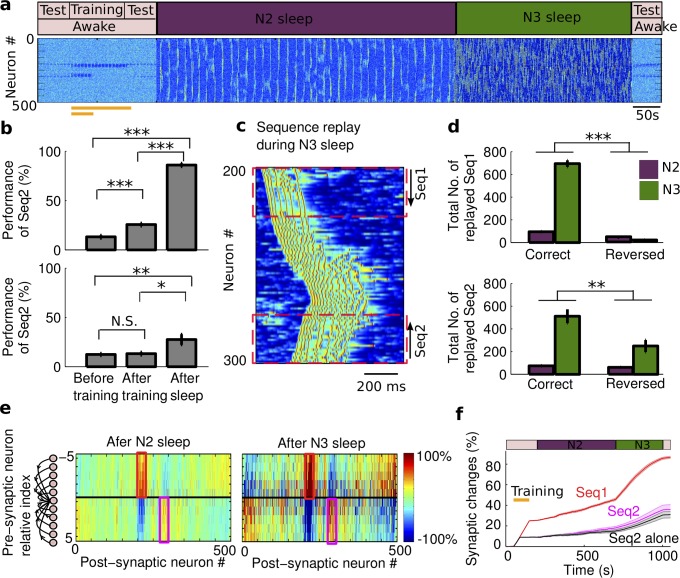
The role of sleep spindles during two-sequence learning.a) The model simulated transitions from awake to N2 sleep, to N3 sleep, and to awake again. Sequence training is the same as in Fig 3. b) The bar plots of performance for Seq1 and Seq2 during test sessions. Note significant increase in Seq2 performance after the sleep. Error bars indicate SEM. c) A characteristic example of sequence replay during slow oscillations. Note, that both Seq1 and Seq2 can be replayed during the same Up state of slow oscillation. d) The bar plots of the replay count for Seq1 and Seq2 during N2 (purple) and N3 (dark green) sleep. Error bars indicate SEM. Note that for both sequences number of correct order replays (“A1B1C1D1E1” for Seq1 and “E2D2C2B2A2” for Seq2) was higher than the number of reversed order replays. e) The change of synaptic weights relative to the initial values after N2 (right) and after subsequent N3 sleep (left). The synaptic change after training is the same as in 4j). The enough amount of sleep spindles enhanced synaptic connections associated with both sequences independently. f). The progressive increase in synaptic weights associated with Seq1 (red), Seq2 (magenta), and Seq2 alone (black). The patch error bar represents standard deviation. * p<0.05, ** p<0.01, *** p<0.001. N.S. represents no significant difference.